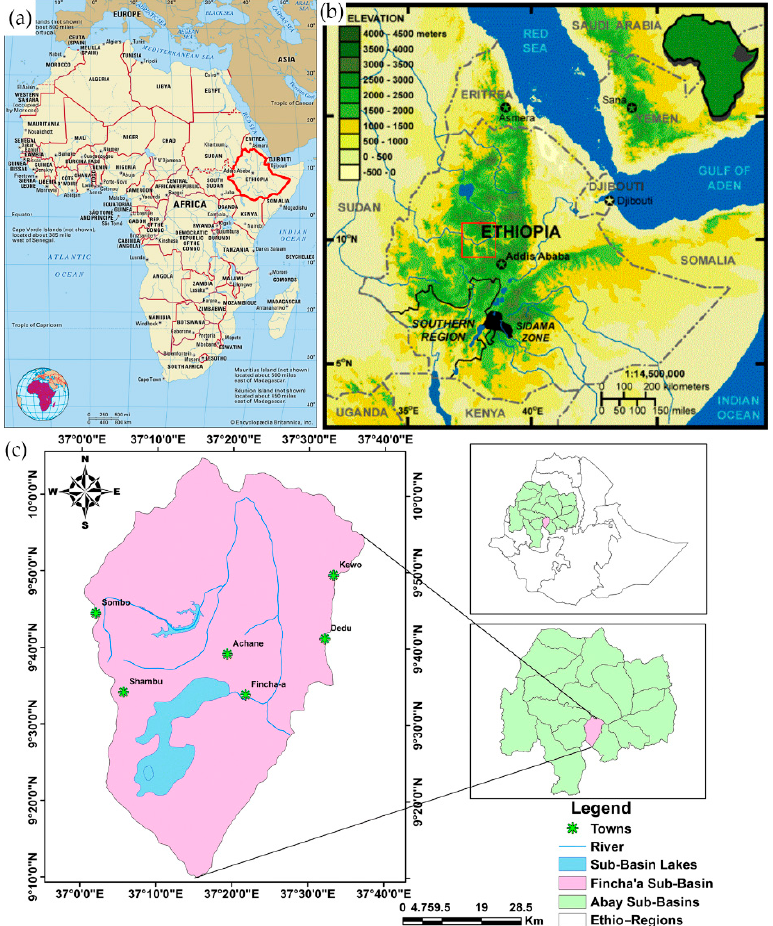
Figure 1. ( a ) Map of Africa; ( b ) map of Ethiopia with ground elevation; ( c ) location of the Abbay basin (right) and the Fincha’a watershed (left).